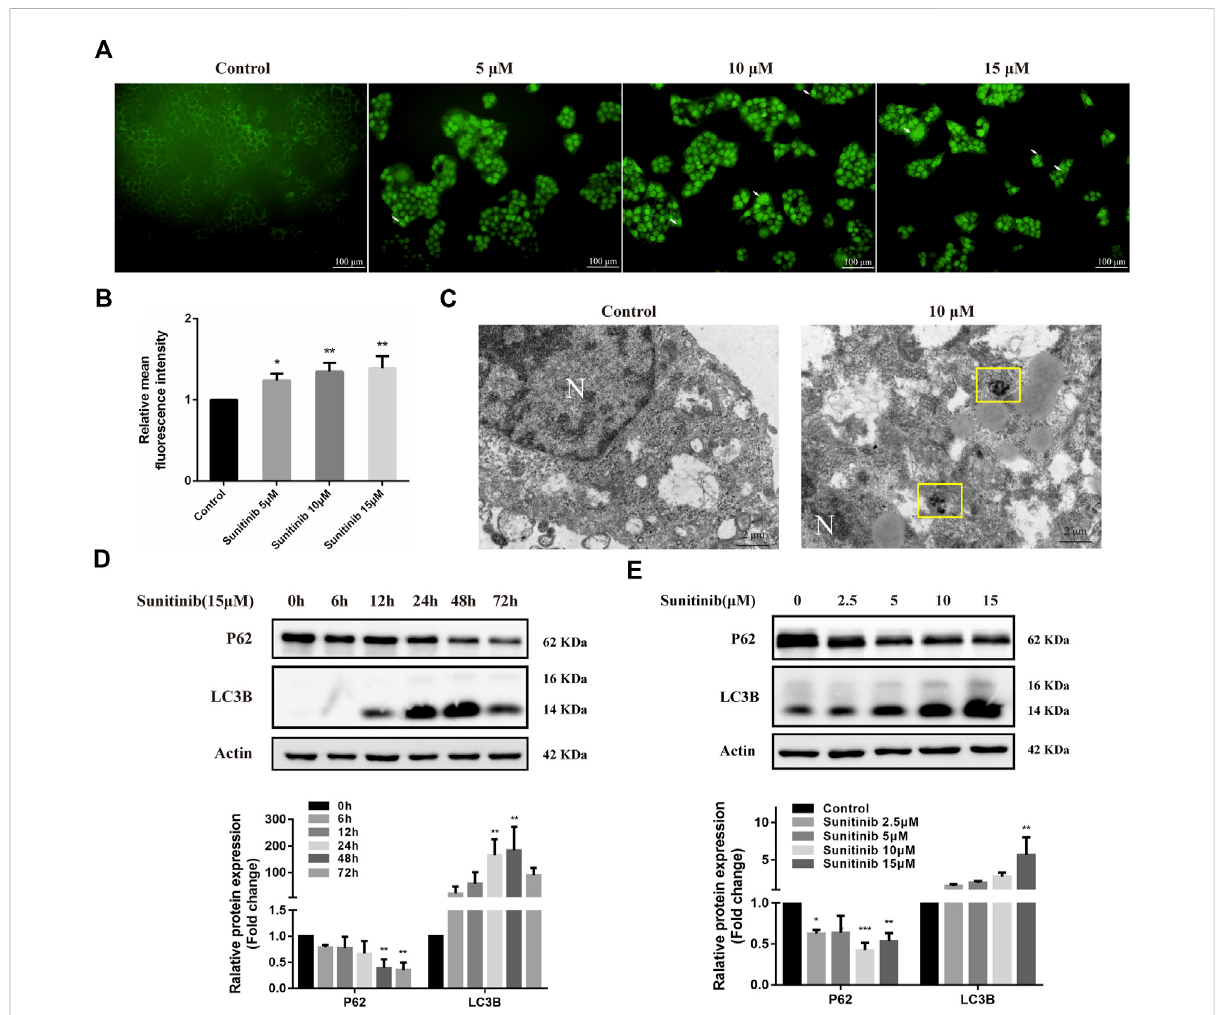
FIGURE 2 Sunitinib leads to autophagy. (A) Autophagic vacuoles were detected by MDC staining after Sunitinib exposure at 0, 5, 10, 15 μ M for 48 h, and autophagosomes were observed on fl uorescence microscopy (scale bars = 100 μ m). White arrows denote autophagosomes. (B) Quanti fi cation of MDC intensities ( n =3). (C) Autophagosomes weredetected byTEMafter Sunitinibexposure at0,10 μ Mfor 48 h(scale bars=2 μ m). Yellowsquares denote autophagosomes. N, nuclear. (D) P62 and LC3B levels in L02 cells incubated with Sunitinib (15 μ M) for 0, 6, 12, 24, 48, 72 h were measured ( n = 3). (E) P62 and LC3B protein expressionin L02 cells incubated with Sunitinib (0, 2.5, 5, 10, 15 μ M) for 48 h were measured ( n = 3). * p < 0.05, ** p < 0.01 and *** p < 0.001 vs. Control